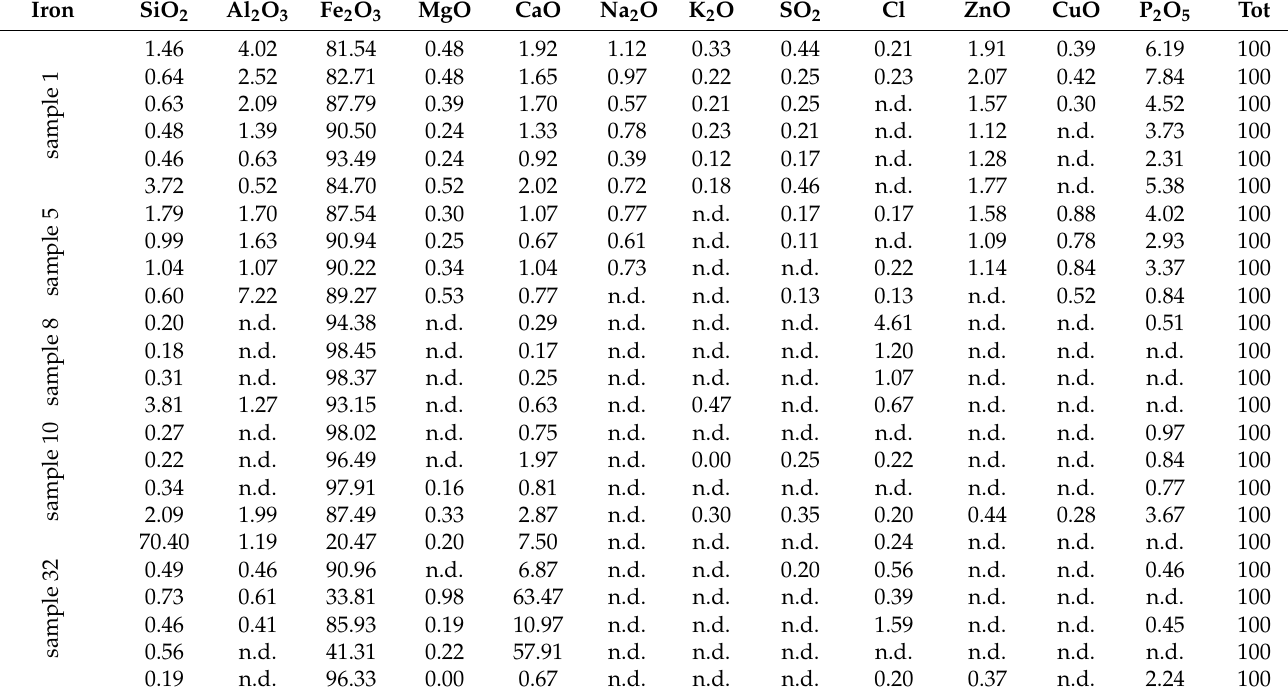
Table 2. SEM-EDS data analysis of all the iron samples analyzed and expressed as oxides in percent- age. The second column explains the specific AREA detected in the samples. Samples 8, 10 and 32 were incorporated into the resin and sectioned. n.d. means not